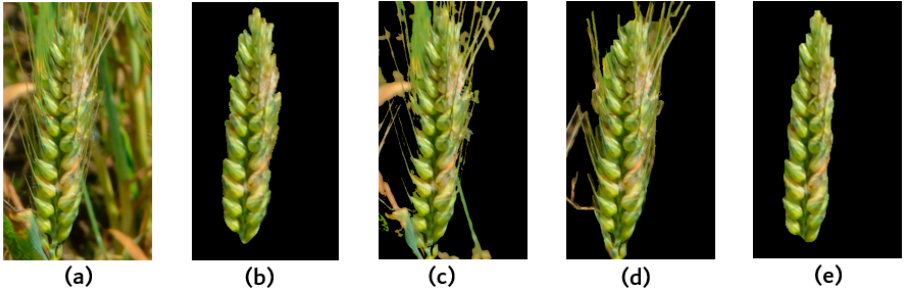
Figure 7. Segmentation results of single wheat ear. ( a ) Original image, ( b ) ground truth, ( c ) K-means segmentation result, ( d ) edge detection segmentation result, ( e ) proposed model segmentation result.